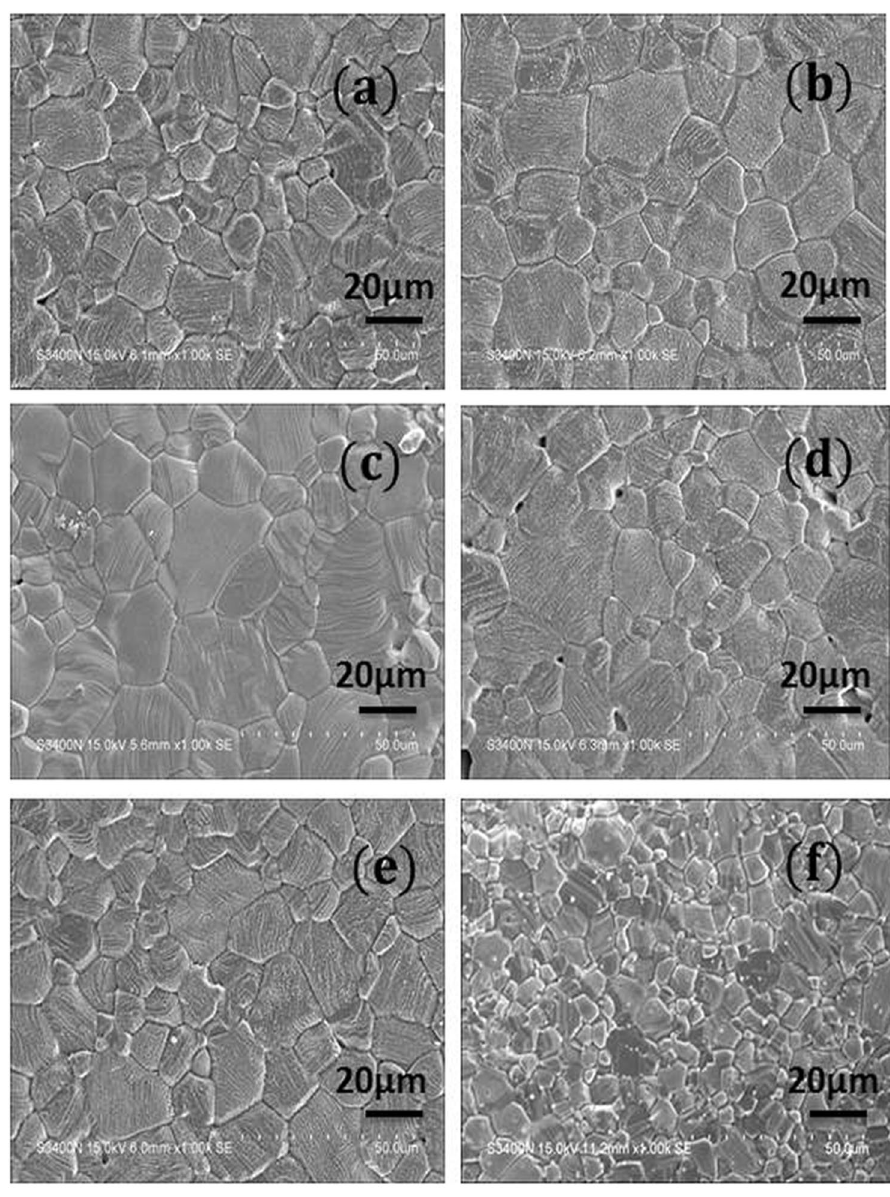
Figure 2. ( a , b ) Scanning electron micrographs of the NC and MC sintered cobalt ferrite samples respectively; ( c – f ) Scanning electron micrographs of sintered pellets of x = 0.05, 0.1, 0.2, 0.4 samples,